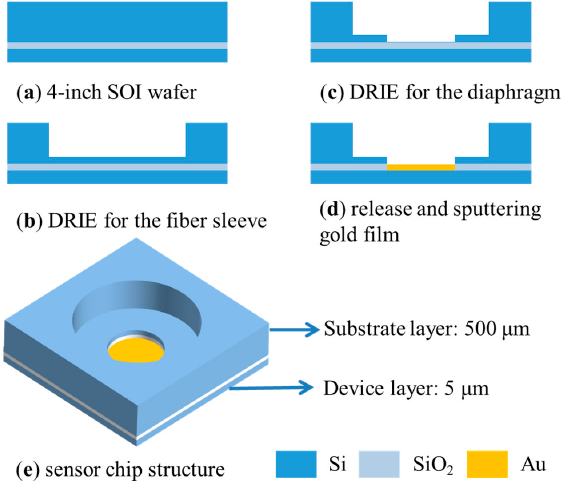
Figure 3. The schematic of fabrication process and the sensor chip structure. SOI, silicon-on-insulator; DRIE, deep reactive ion etching.